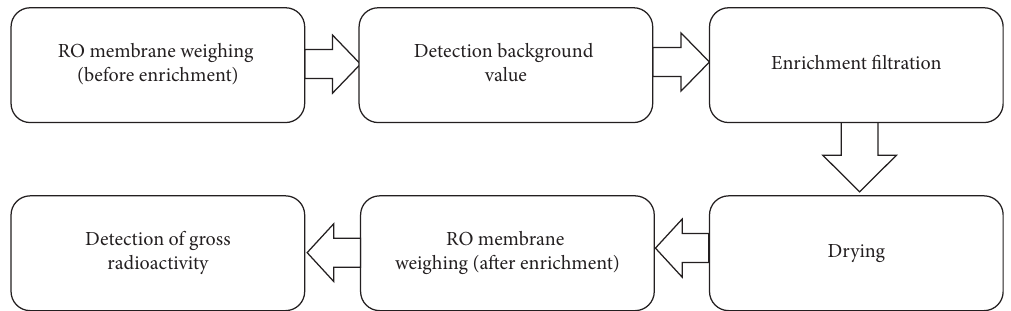
Figure 2: Reverse osmosis membrane method overall operation